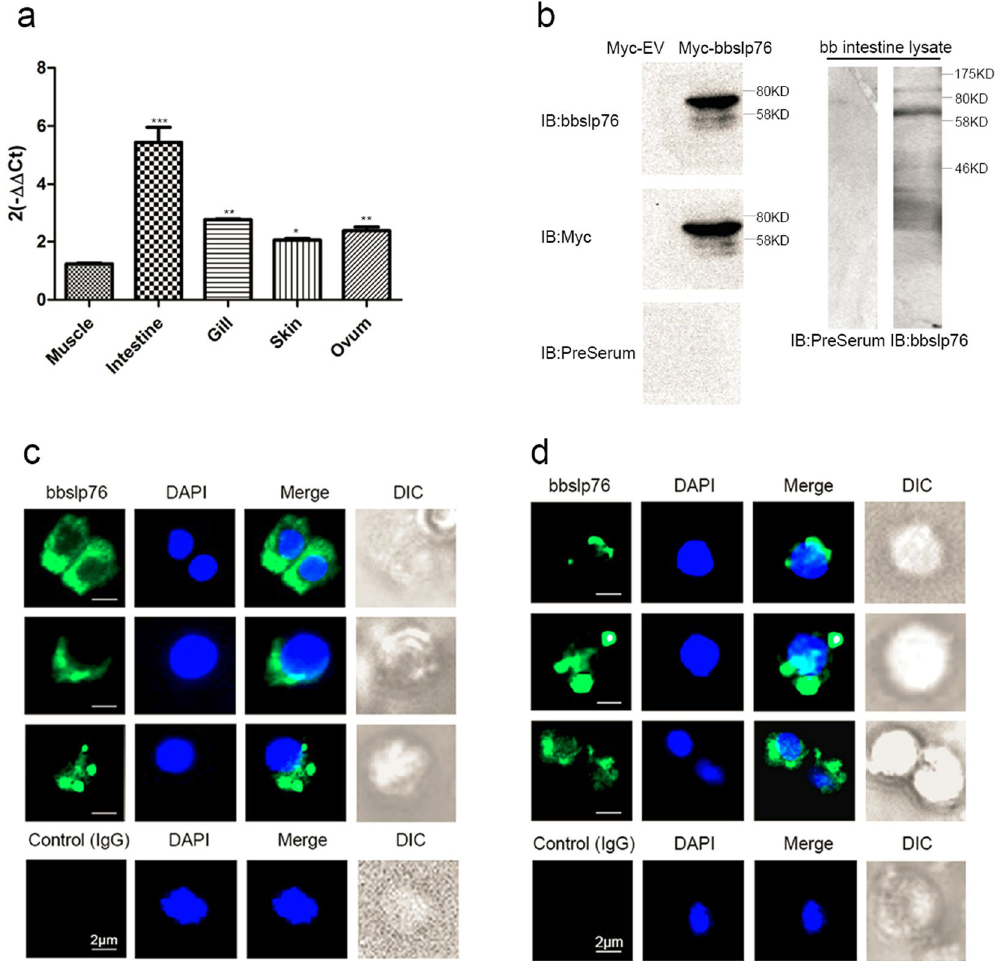
Figure 2. Tissue expression patterns of bbslp76. ( a ) Relative expression levels of bbslp76 gene in various tissues of B. belcheri by qRT-PCR. 2- ΔΔ Ct values (normalized to endogenous control 18S) represented the expression of the bbslp76 gene in various tissues (muscle, intestine, gill, skin, ovum) of B. belcheri . Bars represent the average results of triplicate reactions for each tissue. Error bars represent the standard error of the mean (SEM) among three biological replicates. * , ** and *** indicate a significant expression level difference versus muscle as control at p < 0.05, p < 0.005 and p < 0.005, respectively. ( b ) bbslp76 polyclonal antibody titration (1:1000) in 293 T cells with exogenous expression of cMyc-bbslp76 and in amphioxus intestine lysate respectively. EV: Empty Vector. ( c ) and ( d ) Localization of bbslp76 in the gill ( c ) or intestine cells ( d ) of amphioxus. Amphioxus gill or intestine cells were bound to poly-L-Lysine-coated coverslips, fixed, and stained with anti-bbslp76 polyclonal antibody followed by a secondary fluorescent antibody (green). Nuclei were stained with DAPI (blue). Images were acquired using fluorescent microscopy at 400 times magnification. Bar = 2 μ